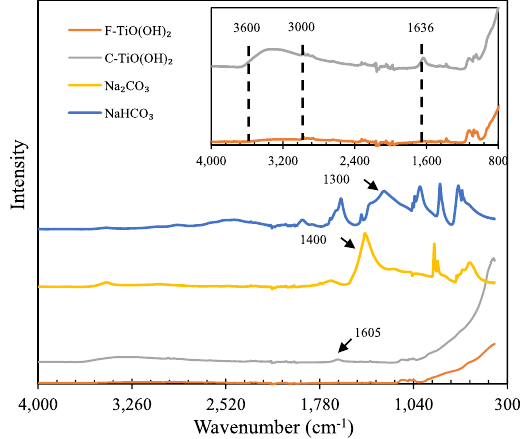
Figure 6. FT-IR spectra of F-TiO(OH) 2 , C-TiO(OH) 2 , Na 2 CO 3 , and NaHCO 3 .